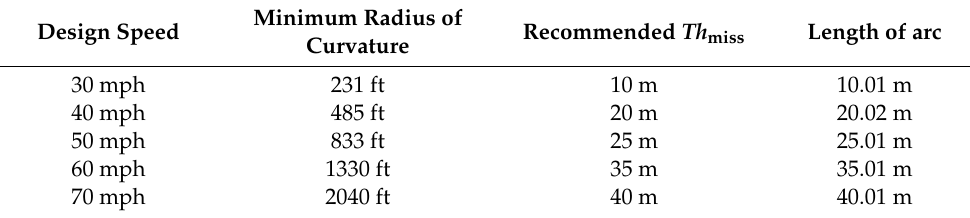
Figure 16. Illustration of ( a ) lane marking centerline grouping and ( b ) interpolation for filling the gap which is larger than Th dist and less than Th miss (adapted from Ravi et al. [18]). Table 3. Recommended values of Th miss at different design speeds.